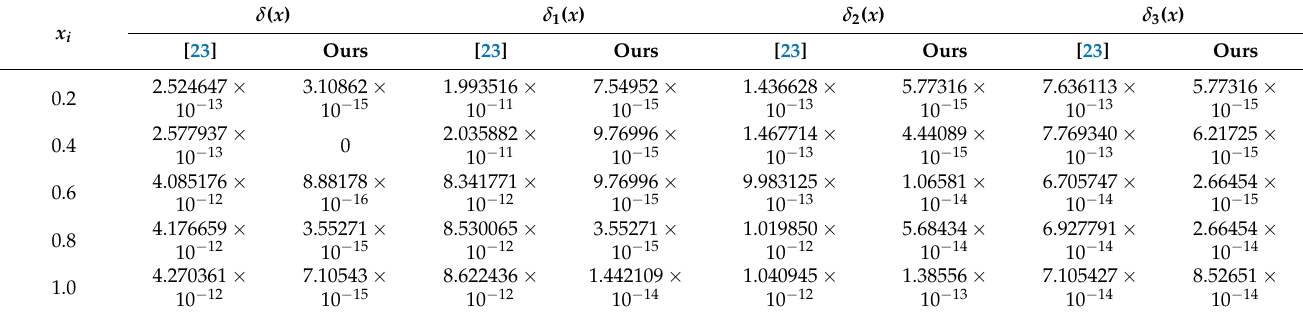
Table 3. The absolute errors of different δ ( x ) for Example 2.